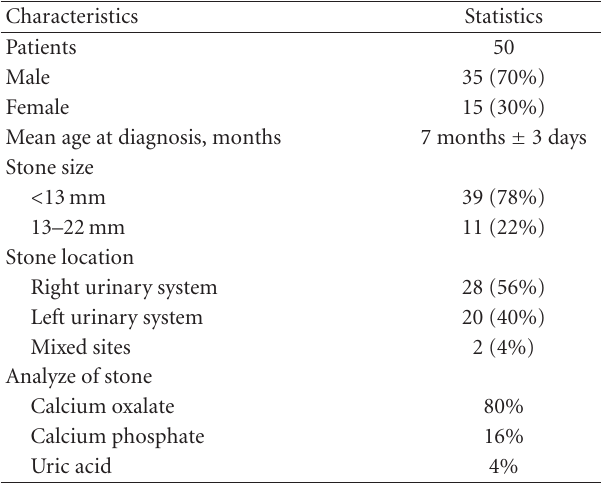
Table 1: Clinical, demographical, and stone analysis data of pa- tients with